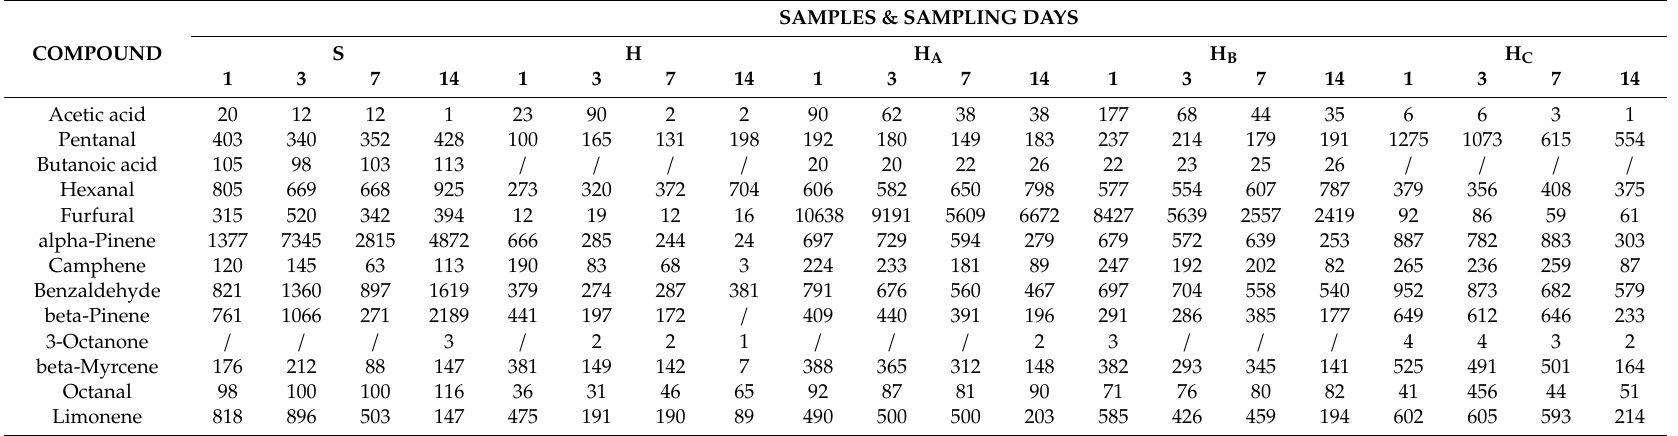
Table 2. The intensities of monitored VOC emissions; intensities detector response for unique mass: (S—spruce strands, H—untreated hemp shive, H A —hemp shive after tartaric acid treatment, H B —hemp shive after citric acid treatment, H C —hemp shive after sodium bicarbonate